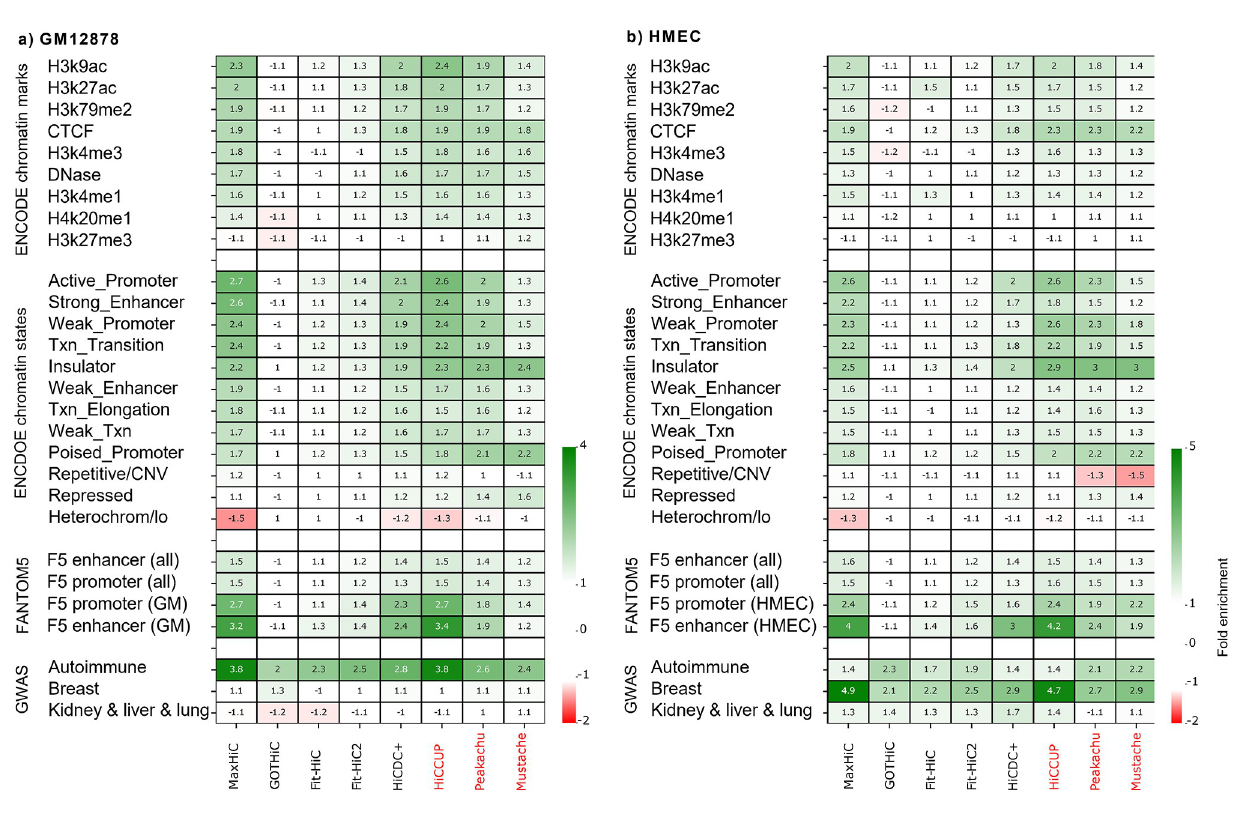
Fig 2. Enrichment of regulatory potential in regions identified by MaxHiC and other tools. a) Enrichment of GM12878 specific histone marks, putative regulatory regions and GWAS signal in regions identified by MaxHiC in the Rao et al . [5] GM12878 dataset. b) As in (a), but enrichment of signals in the HMEC dataset are shown. ENCODE chromatin states are from GM12878 and HMEC data respectively. For FANTOM5, enrichment is shown for all FANTOM5 promoters and enhancers and for those only active in GM12878 and HMEC. GWAS SNPs for autoimmune disease, breast and kidney/liver/lung disorders ( S4 Table ) were downloaded from Maurano et al . [29]. Note: HiCCUPS calls interactions with FDR < 0.05 as significant. For all other methods we used a threshold of P-value < 0.001 to identify significant